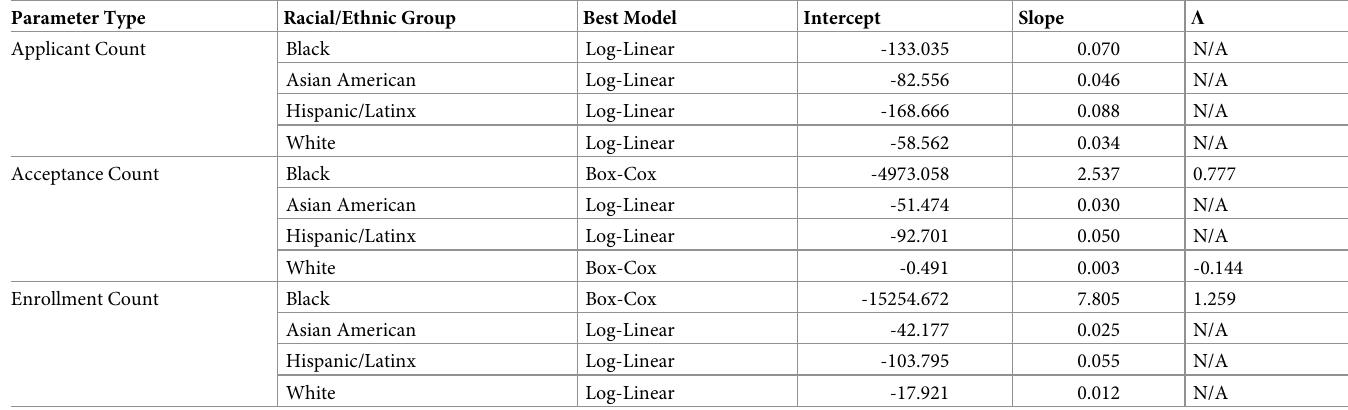
Table 1. Regression models for applications, acceptances, and enrollment at University of California-Berkeley. Our Markov chain model (see Fig 1) requires specifica- tion of the parameters δ , α , and � , which are probabilities derived from counts of applicants, acceptances, and enrollments. These counts must be specified for each year and for each racial/ethnic group. We assess the fit of linear, log-linear, and optimal Box-Cox models on historical data. We choose the preferred model, specified in the table above, and use it to forecast future values. Fig 3 shows various models for application count, corresponding to the top section of the table. The column labeled Λ is an exponent used in the Box-Cox transformation, and thus is relevant only to those